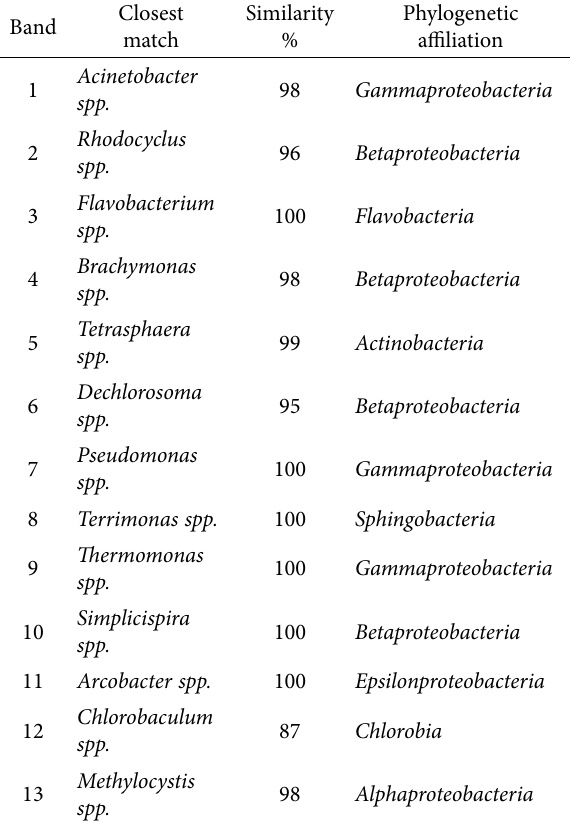
Table 4. NCBI BLAST search results of sequences from DGGE